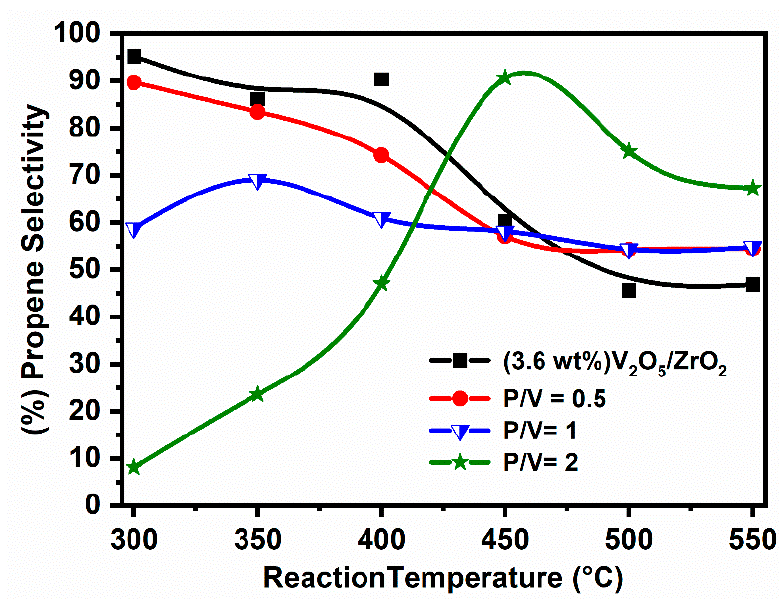
Figure 15. Variation of propene selectivity with reaction temperature and composition.